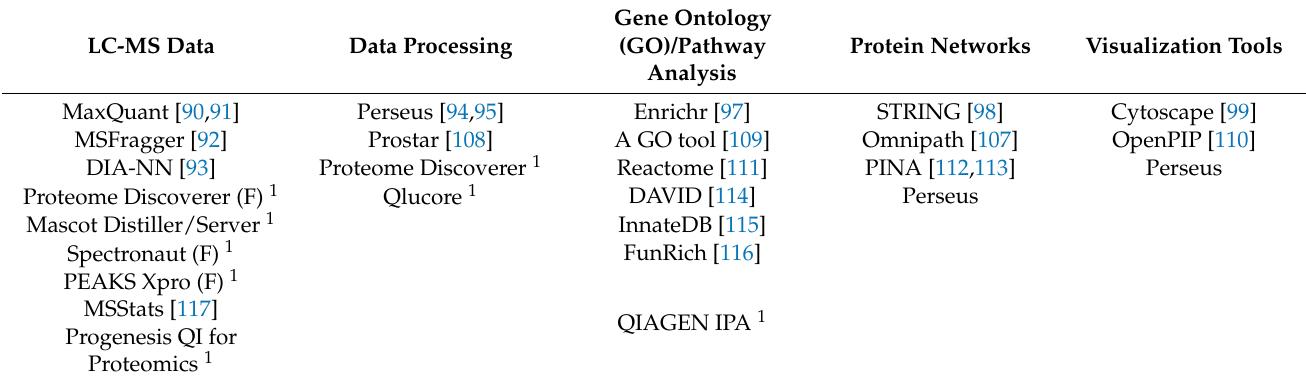
Table 1. Recommended software and online applications * to analyze LC-MS-based proteomics